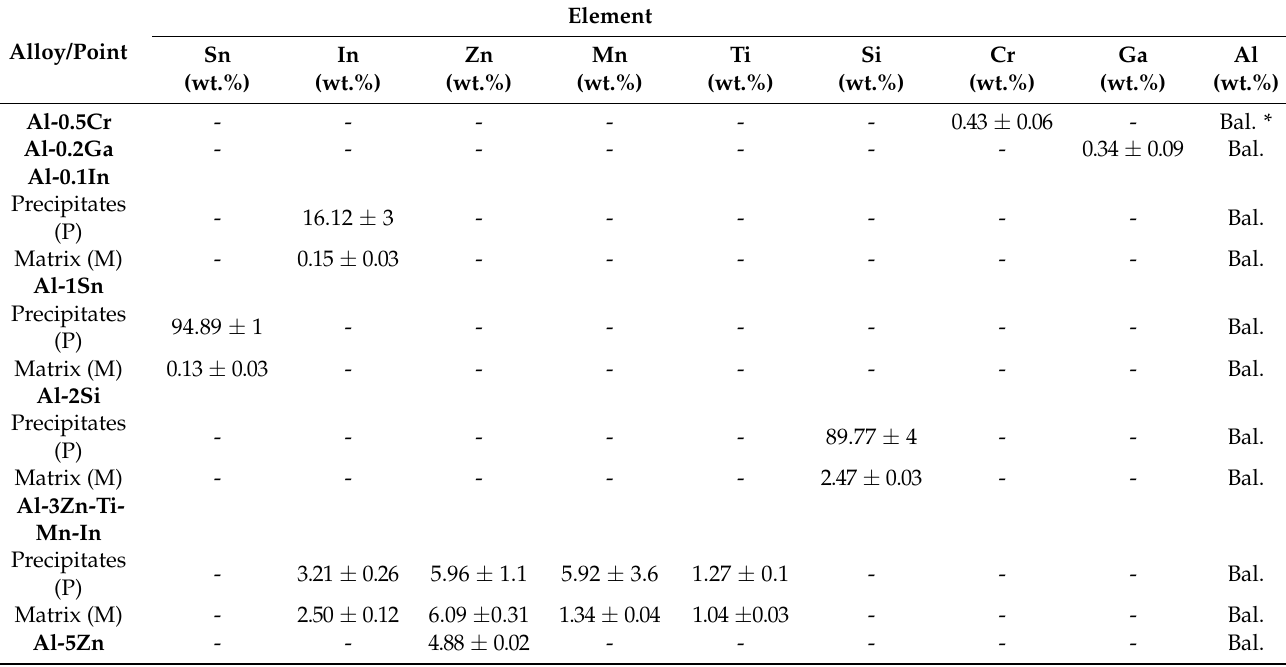
Table 3. SEM-EDS analysis of solution-treated Al-based alloys.